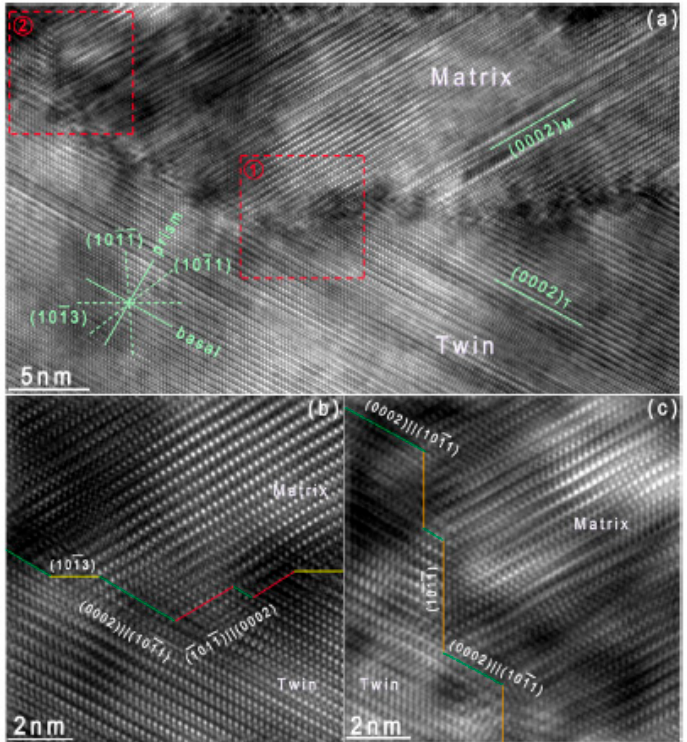
Figure 6. ( a ) High-resolution transmission electron microscopy showing the morphology of ( 1013 ) twinning boundary. Two positions marked with the red rectangular boxes 1 and 2 in ( a ) are shown in ( b ) and ( c ), respectively, at a higher magnification. In ( b , c ), the 1013 twinning boundaries are denoted by the yellow lines, and the (1011) twin facets are indicated by the orange lines. The (0002)||(1011) basal–pyramidal interfaces and (0002)||(1011) pyramidal–basal interfaces are colored in green and red, respectively. (Reproduced from [51], with permission from Elsevier, 2015).